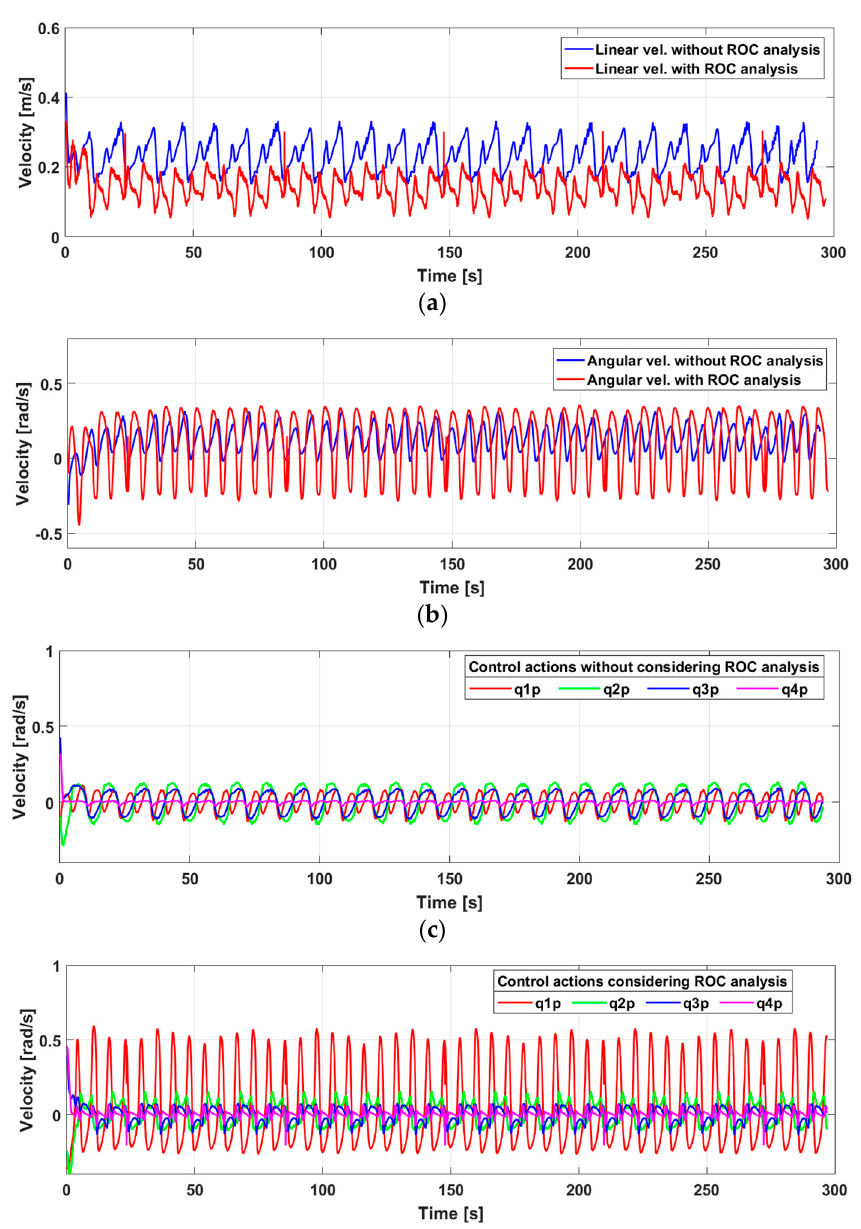
Figure 20. Control velocities for the entire robotic system. ( a ) reduced linear velocity, ( b ) reduced angular velocity, ( c ) reduced linear control actions, ( d ) reduced angular control actions.